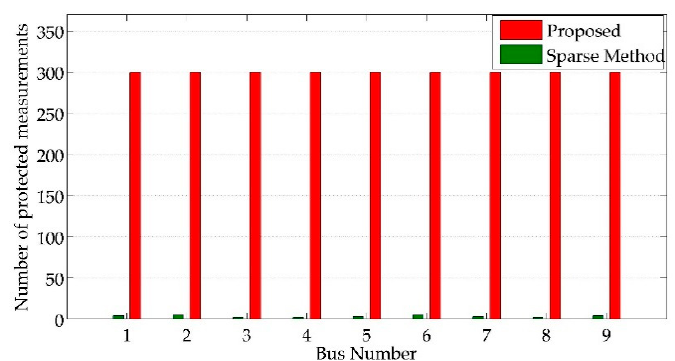
Figure 9. Analysis on the number of protected measurements.